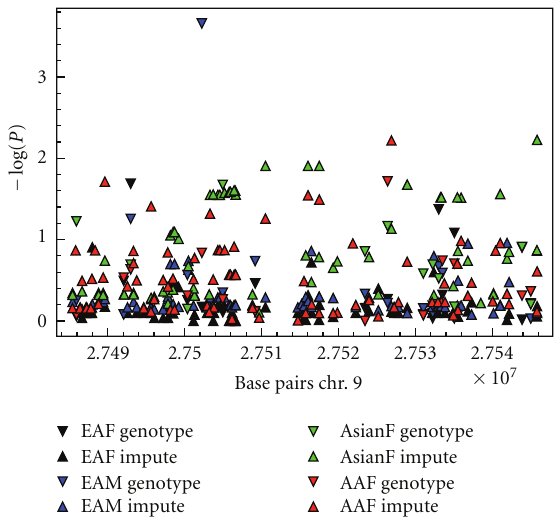
symbol represents an SNP, with downward pointing triangles showing the SNPs directly genotyped and upward pointing triangles indicating the SNPs which were imputed (see methods for details of imputation). Y -axis shows the inverse log of the P value resulting from the case-control chi-square test statistic for each SNP. X -axis shows the location of each SNP in bases along chromosome 9. Each color represents a di ff erent ancestral background/sex included in this analysis. Due to low numbers, African-American (AA) males and Asian males were not included. EA: European ancestry, M: male, and F: